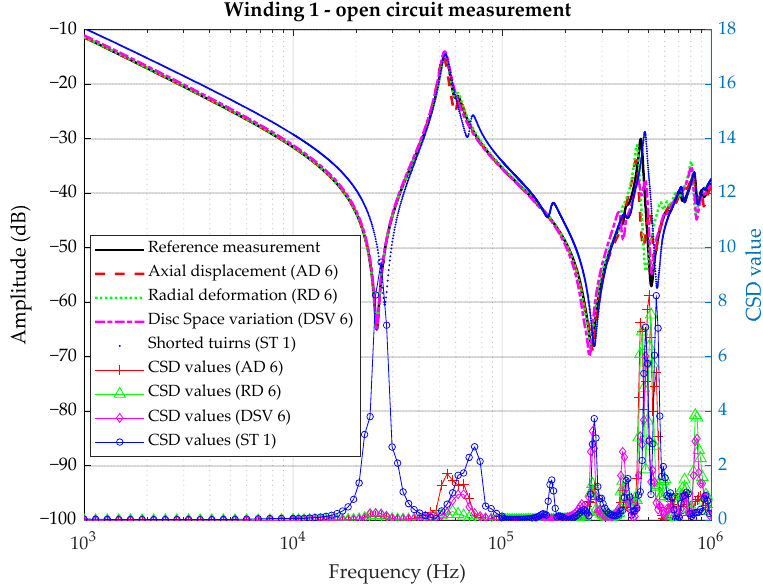
Figure 7. CSD values, calculated for FRA measurements at 40 °C, 20 °C and − 40 °C.